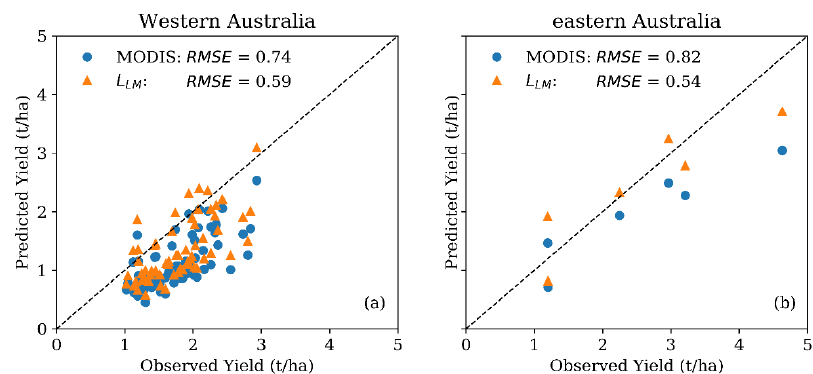
Figure 9. Scattergram for C-Crop-predicted yield against observed values for 2015 at the field level for ( a ) Western Australia ( n = 63) and ( b ) eastern Australia ( n = 6) wheatbelt using MODIS and L–M blended data for gap-filling Landsat ( L LM ) when the fraction of incomplete Landsat series is below 42% for the growing season. The RMSE statistics have units of t/ha.